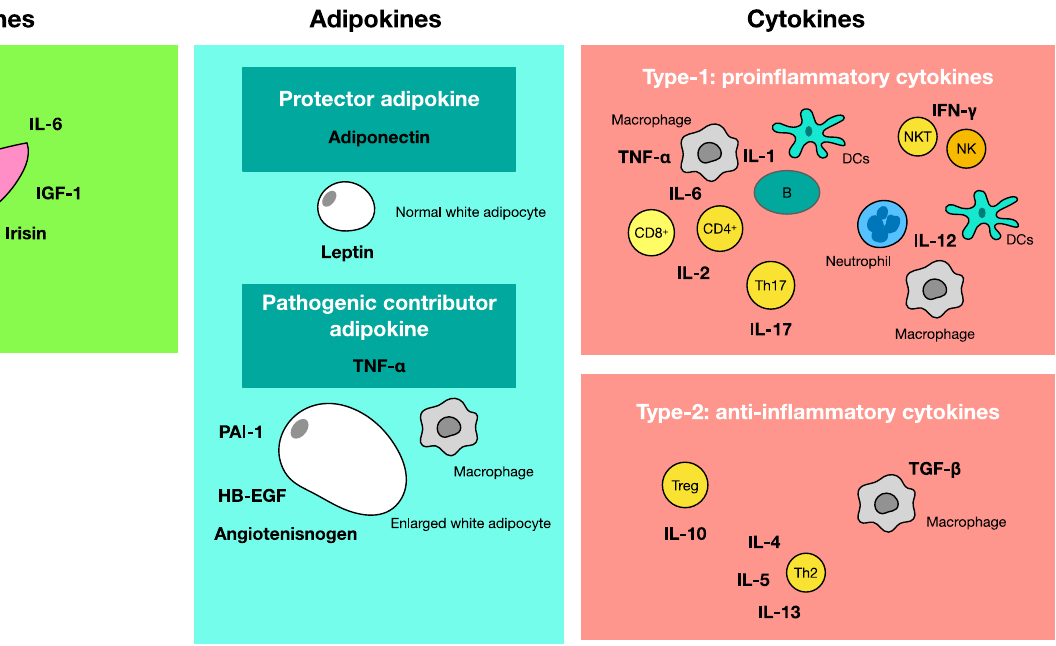
Figure 3. Schematic relationship of adipokines, myokines, and cytokines. This fi gure shows adipokines, myokines, and cytokines and their producing cells. Adipokines include protective adiponectin produced from normal white adipocytes, and pathogenic contributor TNF- α which is produced from enlarged white adipocytes and macrophages. Myokines are produced by muscle cells. Cytokines are physiologically active substances produced by cells in the body. This scheme shows immune regulatory cytokines, namely Type 1 proin fl ammatory cytokines and Type 2 anti-in fl ammatory cytokines. These cytokines are produced from macrophages, dendritic cells, neutrophils, NK cells, NKT cells, T cells, and B cells. CD4 + T cells are classi fi ed into Th1/Th2, Th17, and regulatory T cells (Treg), and each of them produces di ff erent cytokines. TNF- α belongs to both adipokines and proin fl ammatory cytokines. IL-6 is also classi fi ed into proin fl ammatory cytokines and myokines.